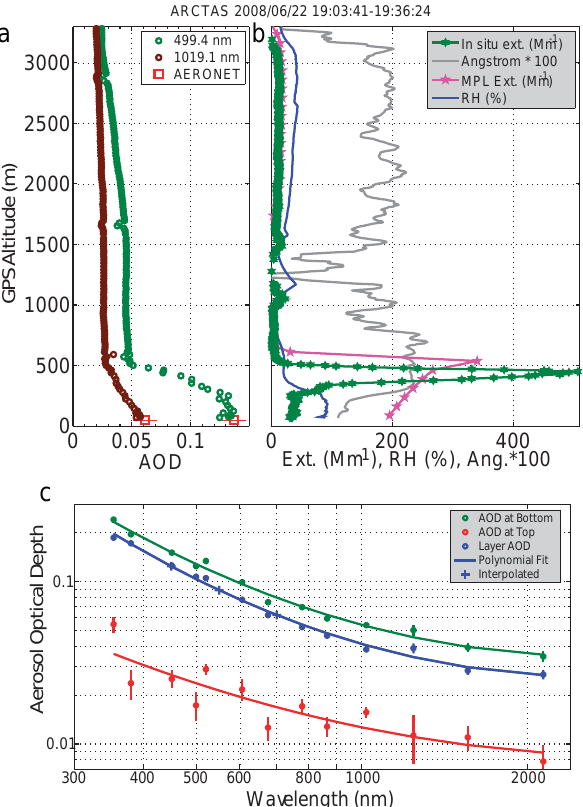
Fig. 3. (a) Vertical profile of above-aircraft AOD observed dur- ing the spiral over Monterey on 19:03:41–19:36:24, 22 June 2008. (b) In situ extinction coefficient and its ˚Angstr¨om exponent during the same ascending profile. The micropulse lidar (MPL) extinc- tion coefficient and ambient RH are also shown. (c) AOD spec- tra observed at the bottom and top of profile. Their difference (layer AOD), a second-order polynomial fit and the values inter- polated to the nephelometer wavelengths are also shown. The fit is ln AOD=0.51(ln λ) 2 − 0 . 97ln λ − 3 . 19 where λ is the wavelength in